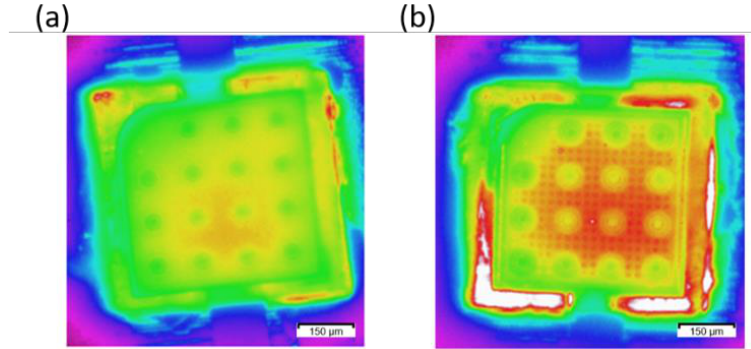
Figure 4. Near field light emission patterns of ( a ) the conventional DUV LED and ( b ) the mesh p-GaN/ITO DUV LED.